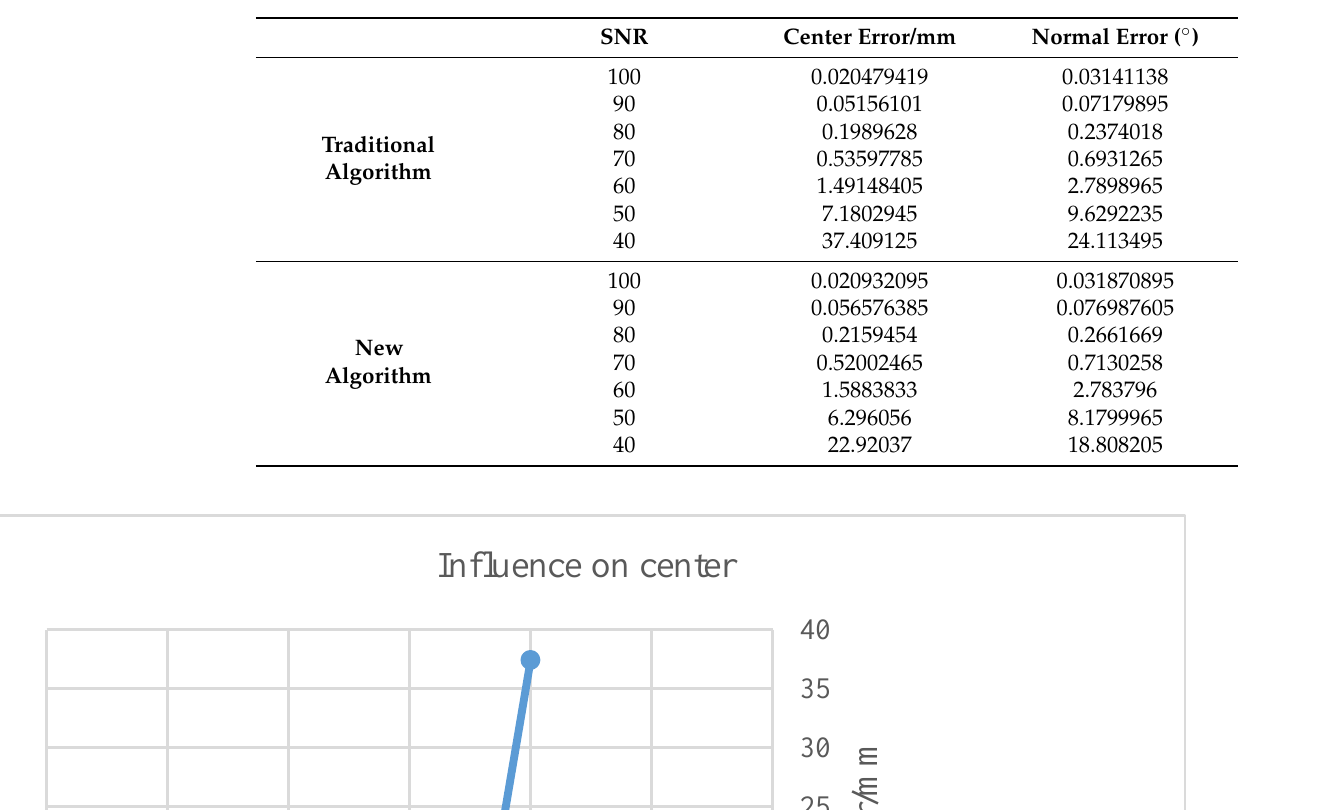
Table 6. Influence of the elliptical edge on space circular target parameters.